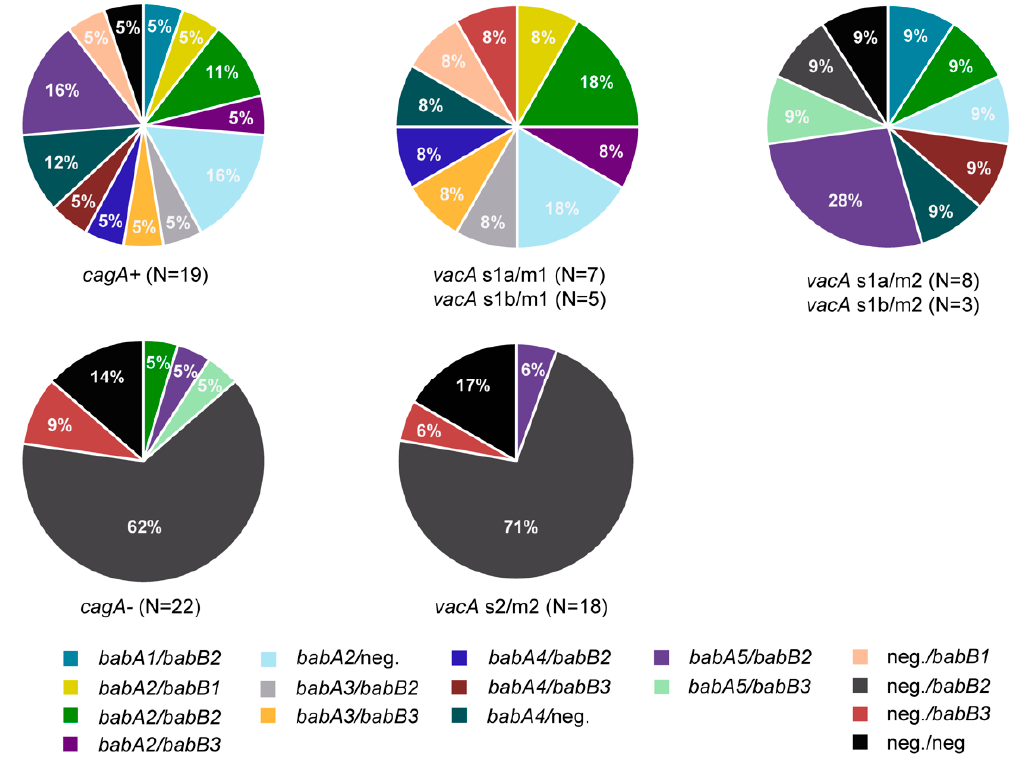
Figure 4. Determination of the presence of different babA and babB alleles and their association with cagA and vacA in 41 H. pylori strains isolated from patients with non-atrophic gastritis.